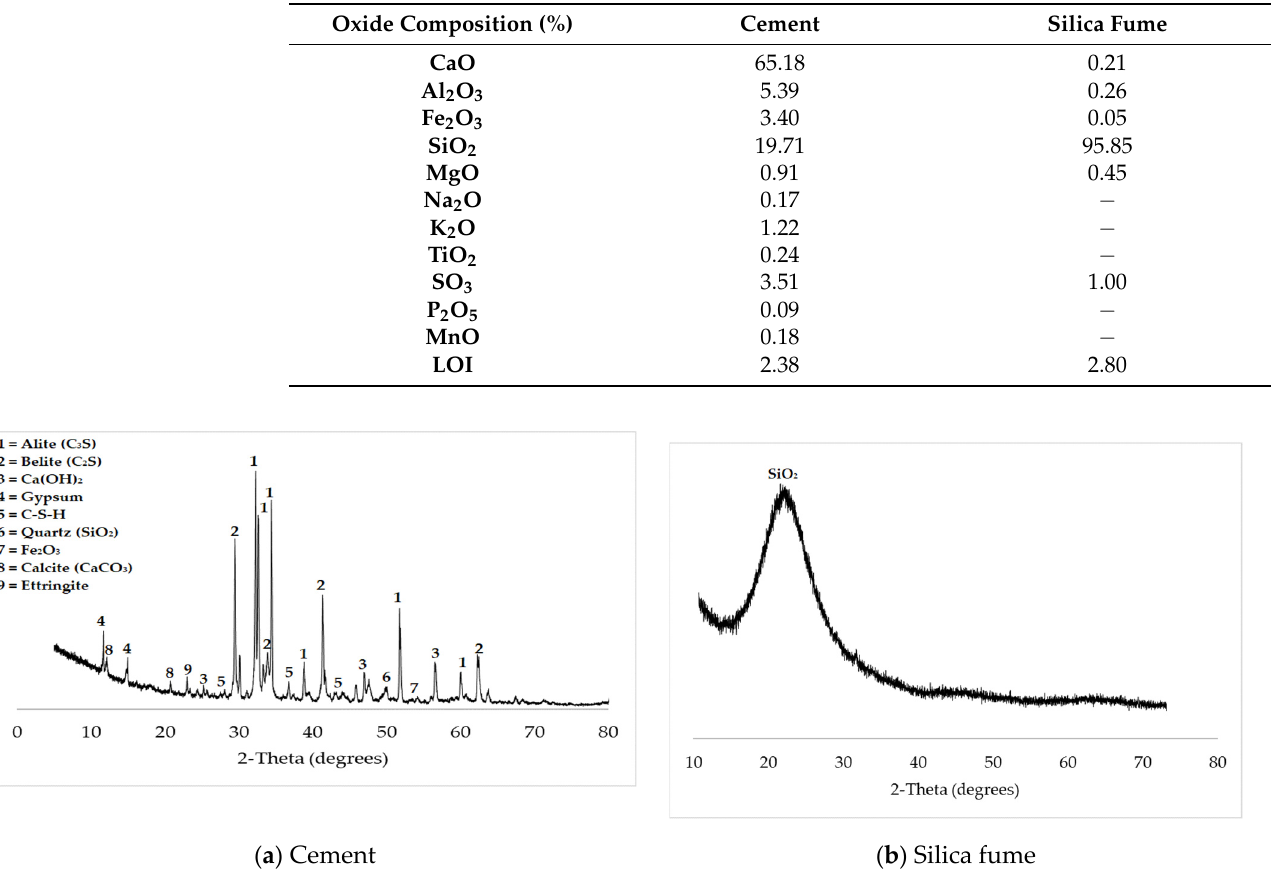
Figure 1. XRD pattern of binder materials.